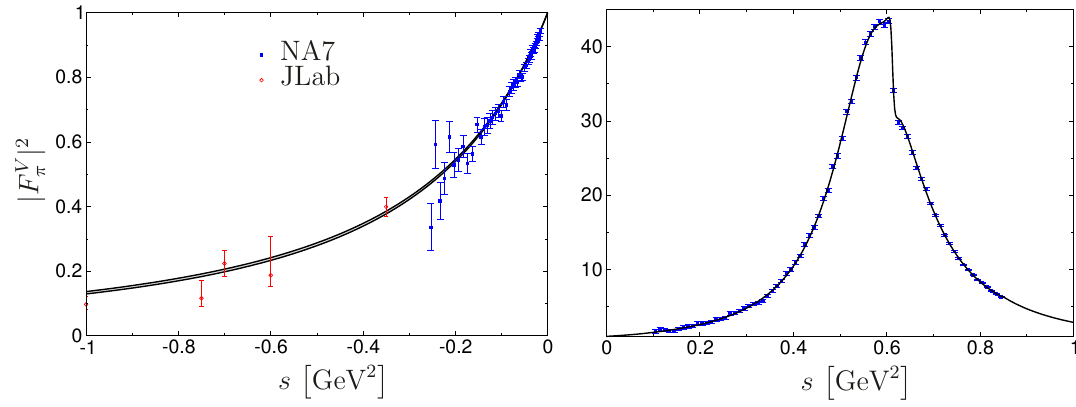
Figure 11. Left: space-like pion form factor from our dispersive (cid:12)t in comparison to data from NA7 [81] and JLab [83{85] (the latter are not included in the (cid:12)t). The error band represents the variation observed between di(cid:11)erent time-like data sets. Right: pion form factor in the time-like region from the combined (cid:12)t to NA7 and [77], chosen here for illustrative purposes only. Fits to the other time-like data sets look very similar and lead to the same numerical results within the accuracy quoted in (3.5)